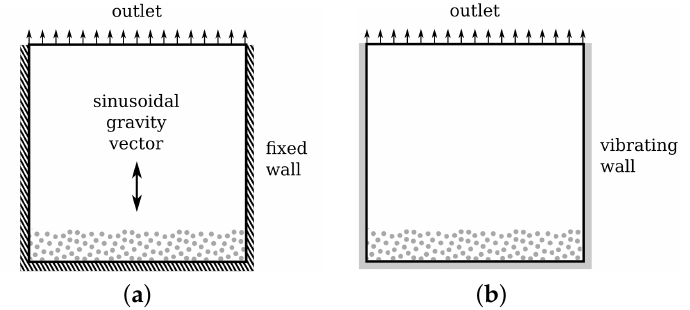
Figure 3. Square geometry used to validate the vibration modelling. ( a ) With sinusoidally varying gravity body force, ( b ) With pseudo-heat flux boundary on granular temperature.